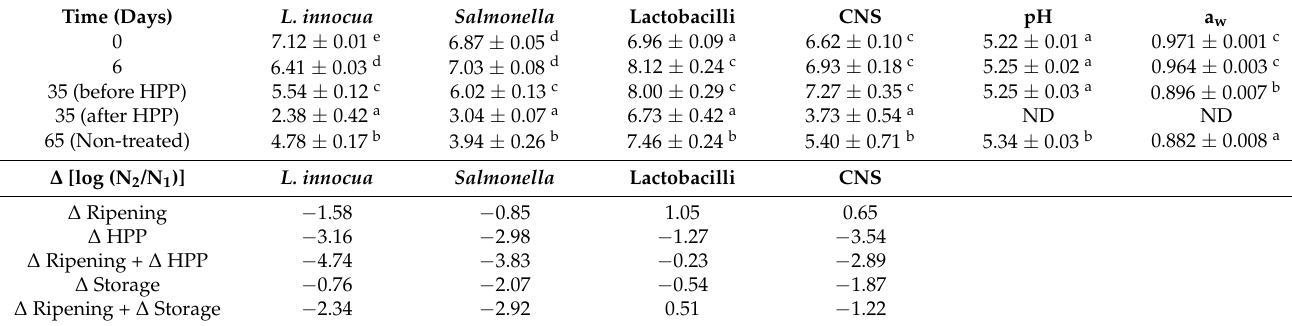
Letters as superscripts indicate significant differences by column based on ANOVA and Tukey’s test ( p < 0.05). HPP: High Pressure Processing. ND: not determined. ∆ Ripening = log CFU/g at the time 0 − log CFU/g at the end of the ripening (35 days before